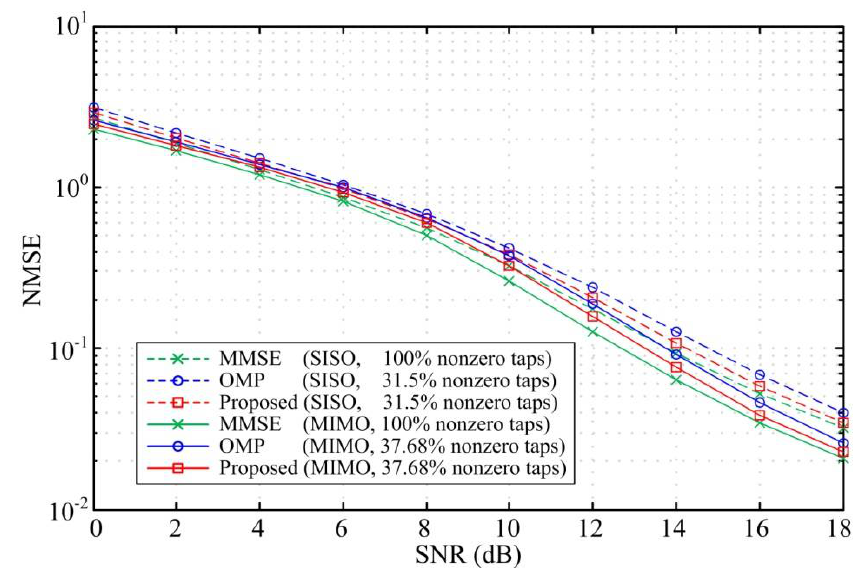
Figure 6. NMSE versus SNR for SISO DFEs and MIMO DFEs in the exponential decay channel with η max = 0.6 dB and N f = 50.